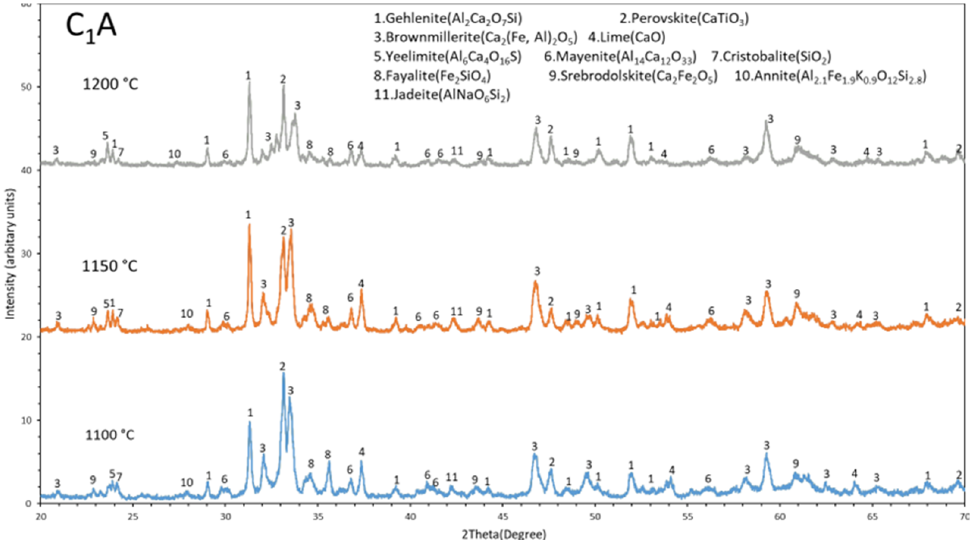
Figure 5. XRD patterns of the C 1 A oxide pellets at different sintering temperatures.